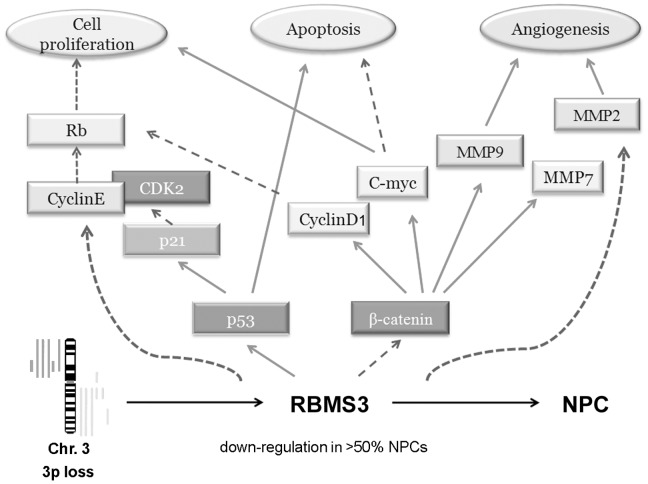
A schematic diagram showing the role of RBMS3 in malignant transformation of nasopharyngeal carcinoma cell.Activation →, inhibition →.